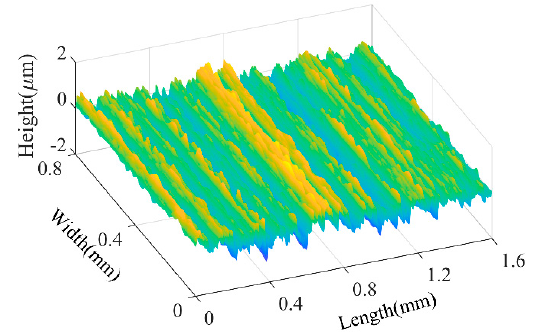
Figure 5. The ground tooth surface topography.